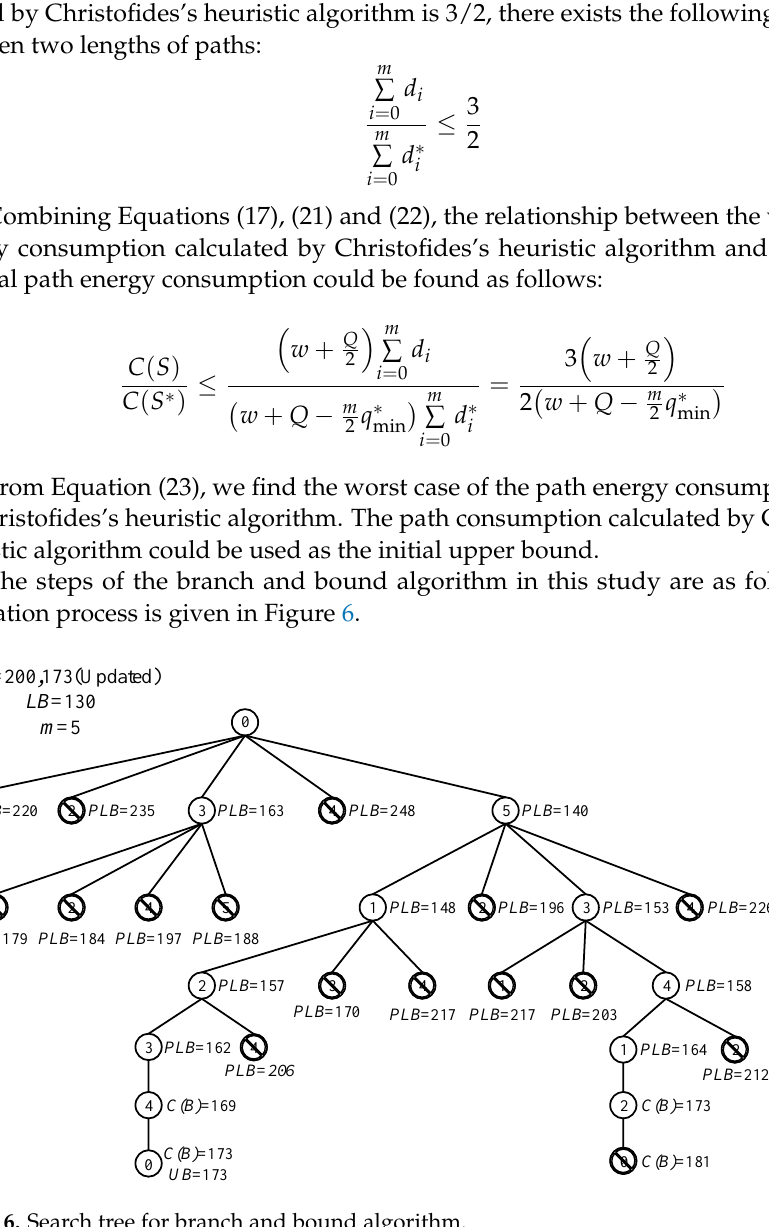
Figure 6. Search tree for branch and bound